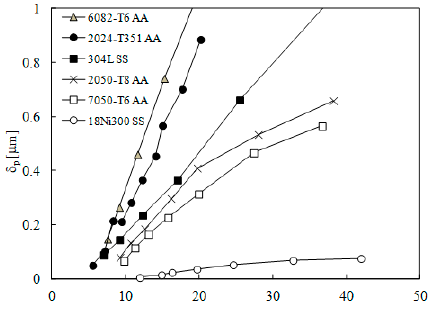
Figure 7. Evolution of plastic CTOD range, δ p , with effective load range (R = 0.01).